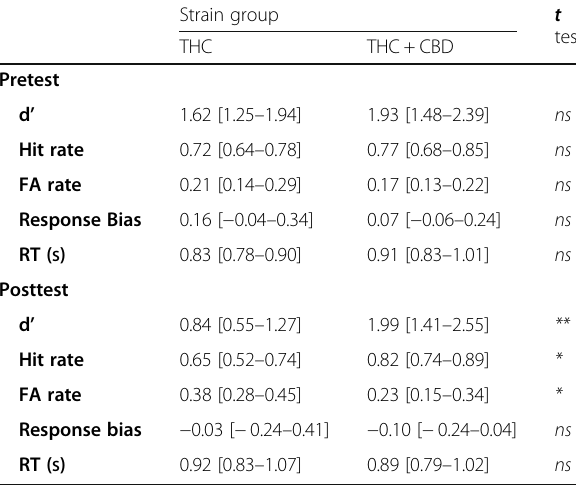
Table 3 d ’ , hit rate, FA (false alarm) rate, c (response bias) and reaction time (RT) for pre- and posttest, for the two strain groups, THC and THC + CBD. Means are reported with 95% within subject confidence intervals in brackets. The right columns indicate significant differences from the t-test on group differences (*: p < .05, **: p <